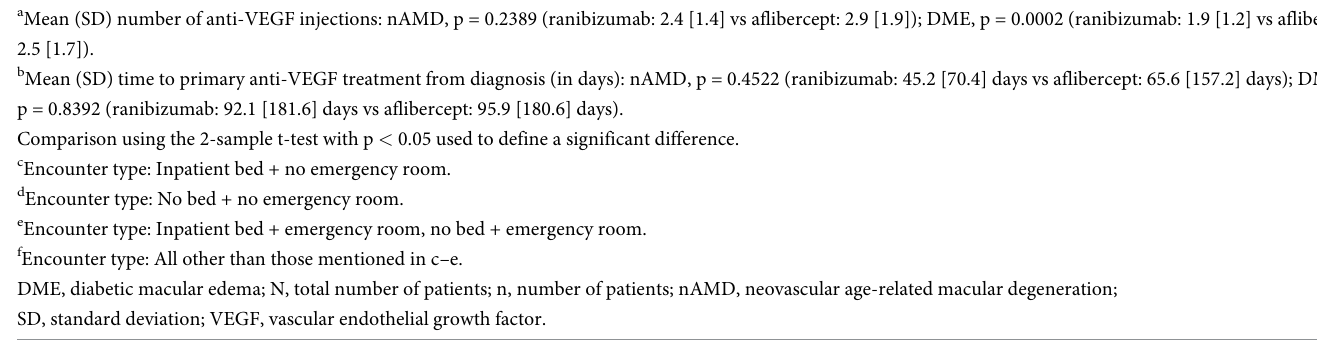
174.8 [83.8] days) for patients with DME. Patients initially treated with ranibizumab received more mean (SD) injections when they switched to another anti-VEGF treatment compared with those treated with aflibercept (nAMD: 2.1 [1.7] vs 1.0 [0.0]; DME: 2.6 [1.6] vs 1.3 [0.7]).